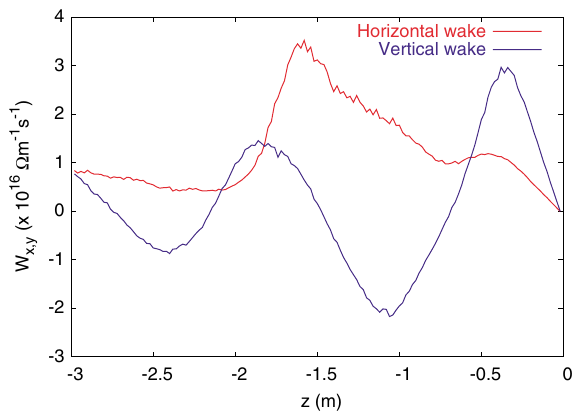
FIG. 8. (Color) Electron cloud horizontal and vertical wake functions for a longitudinally uniform bunch in a combined function magnet (nominal PS parameters, magnetic field gra- dient of 5 : 2 T = m ).